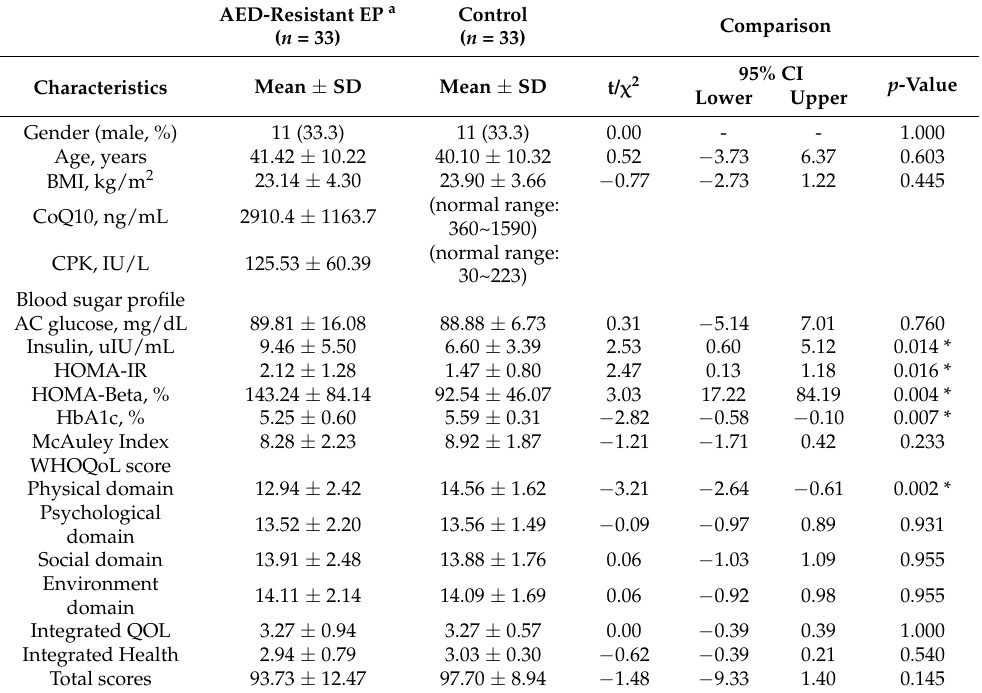
Table 1. Demographic characteristics of the AED-resistant epilepsy patients and the control subjects (1:1 matched age and gender). Control AED-Resistant EP a Comparison ( n = 33) ( n = 33) Characteristics Mean ± SD